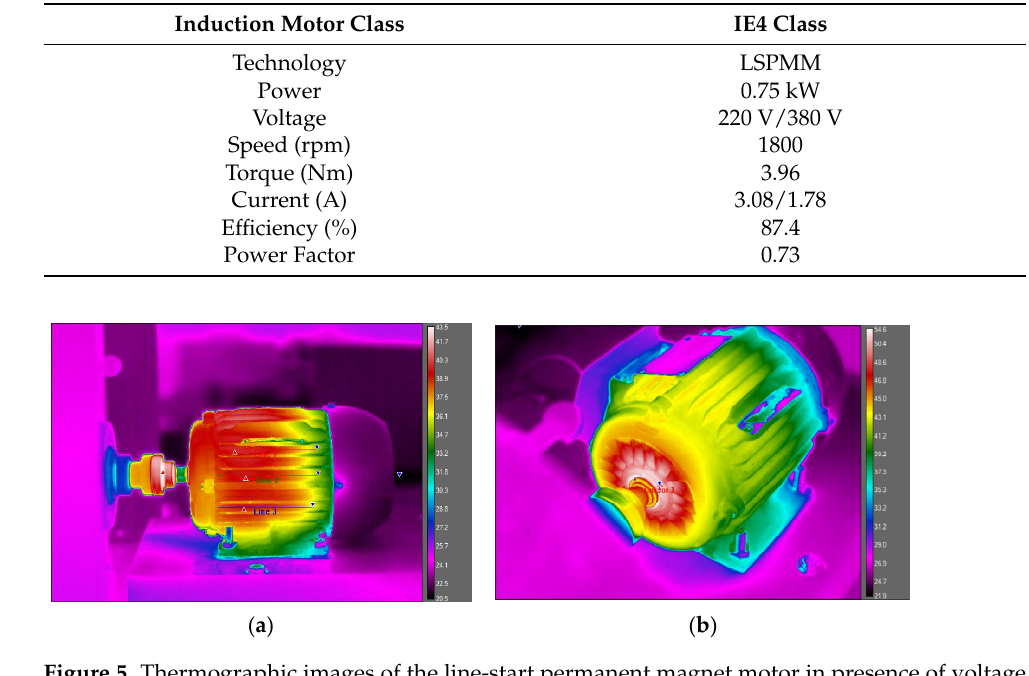
Table 1. Line-start Permanent Magnet Motor Parameters.